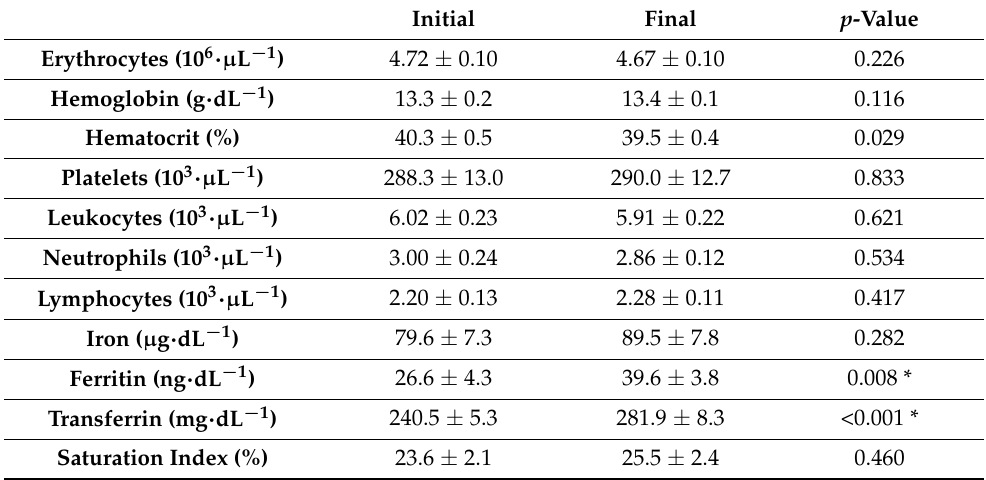
Table 3. Changes in blood cell counts, hematological parameters, and iron metabolism during the study. Initial Final p